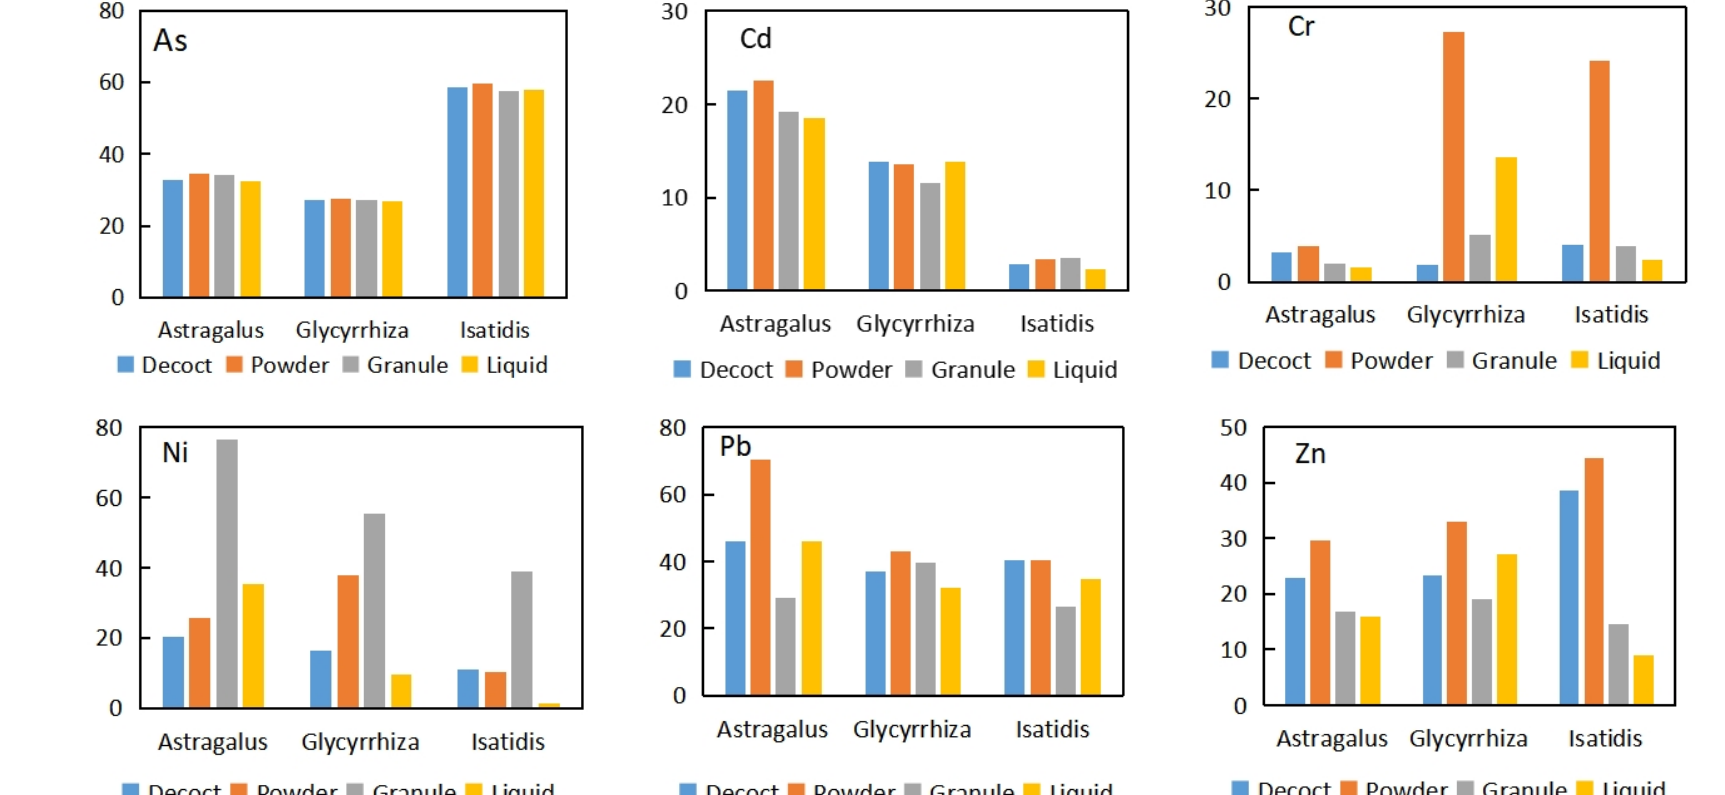
Figure 4. Percentage of the bioaccessible fractions to the total concentration of trace elements in CHMs (%).